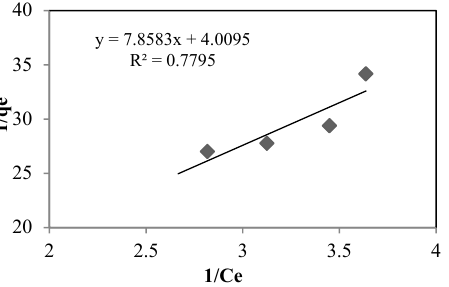
Figure 7. Langmuir (II) isotherm for silica sand coated with Fe(III). As initial : 0.392 mg·L − 1 . T: 22 °C.